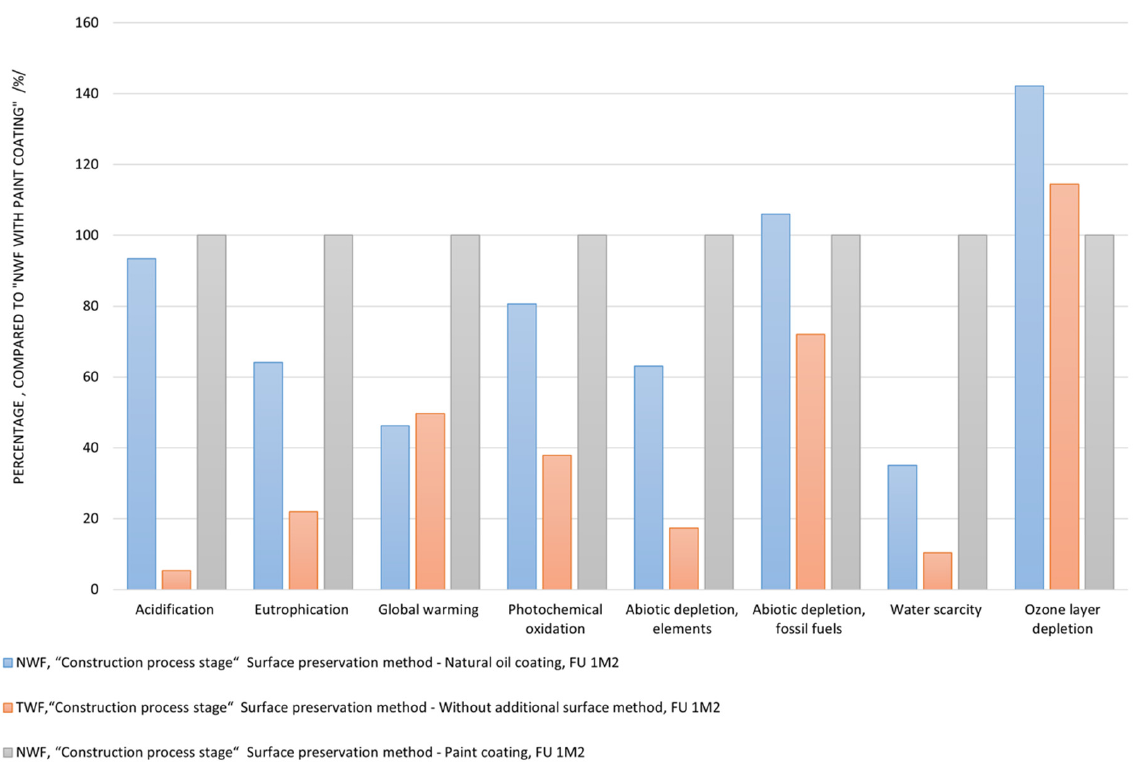
Figure 4. Comparing the “Construction process stage“ for functional unit (FU) (1 m 2 ) of TWF without additional surface treatment and NWF with application of natural oil coating and alkyd paint coating. Method EPD (2018) V1.01. TWF— thermally modified wood façade, NWF—non-heat-treated wood façade.